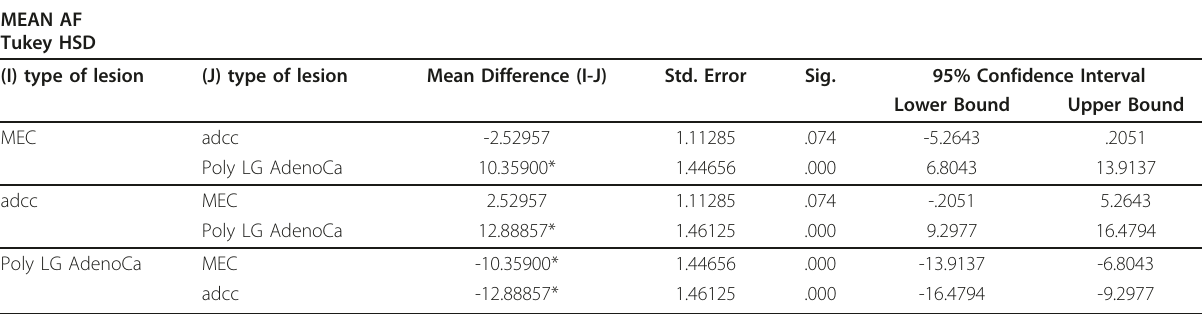
Table 5 Post Hoc Test for MCM2